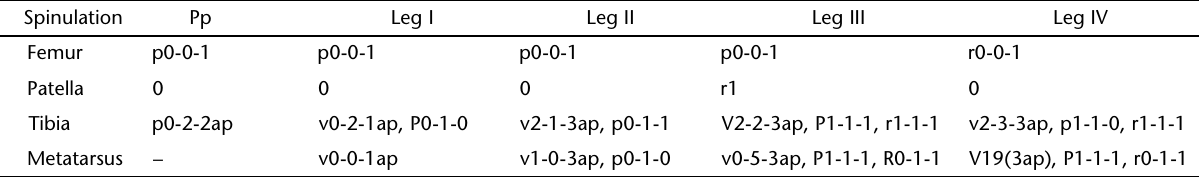
Table VIII. Vitalius nondescriptus comb. nov. Male MZSP 465171 from Ouro Preto, state of Minas Gerais, Brazil (captive born from female MZSP 465351). Spinulation of right legs and palpal segments.